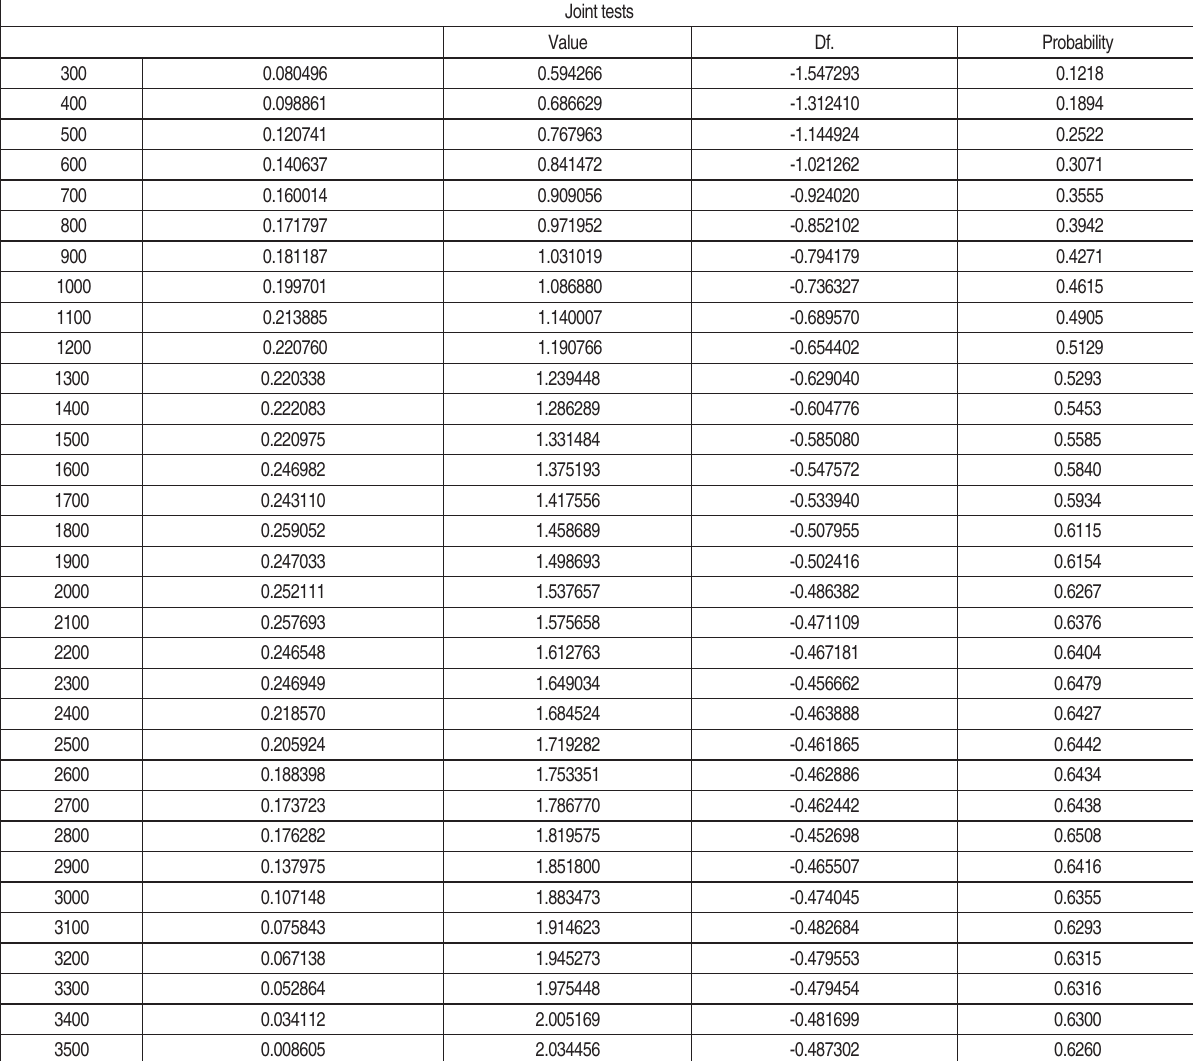
Table 3 (cont.). Variance ratio test of the NSE 20 share index (daily data)